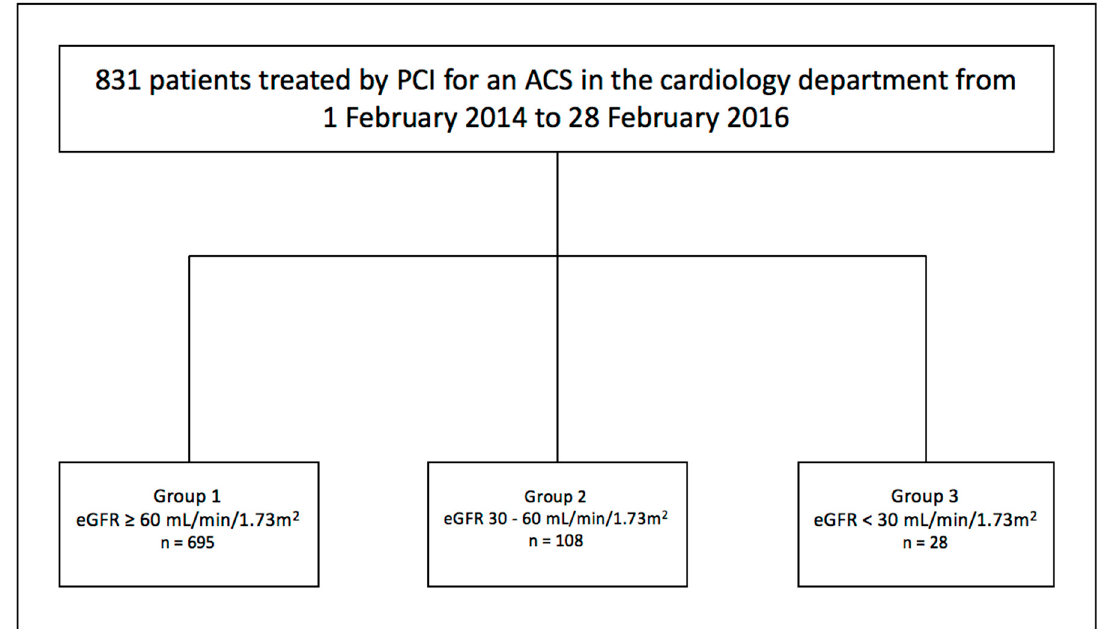
Figure 1. Flow-chart. n : number, ACS: Acute coronary syndrome, eGFR: estimated Glomerular filtration rate, PCI: Percutaneous coronary interventions.